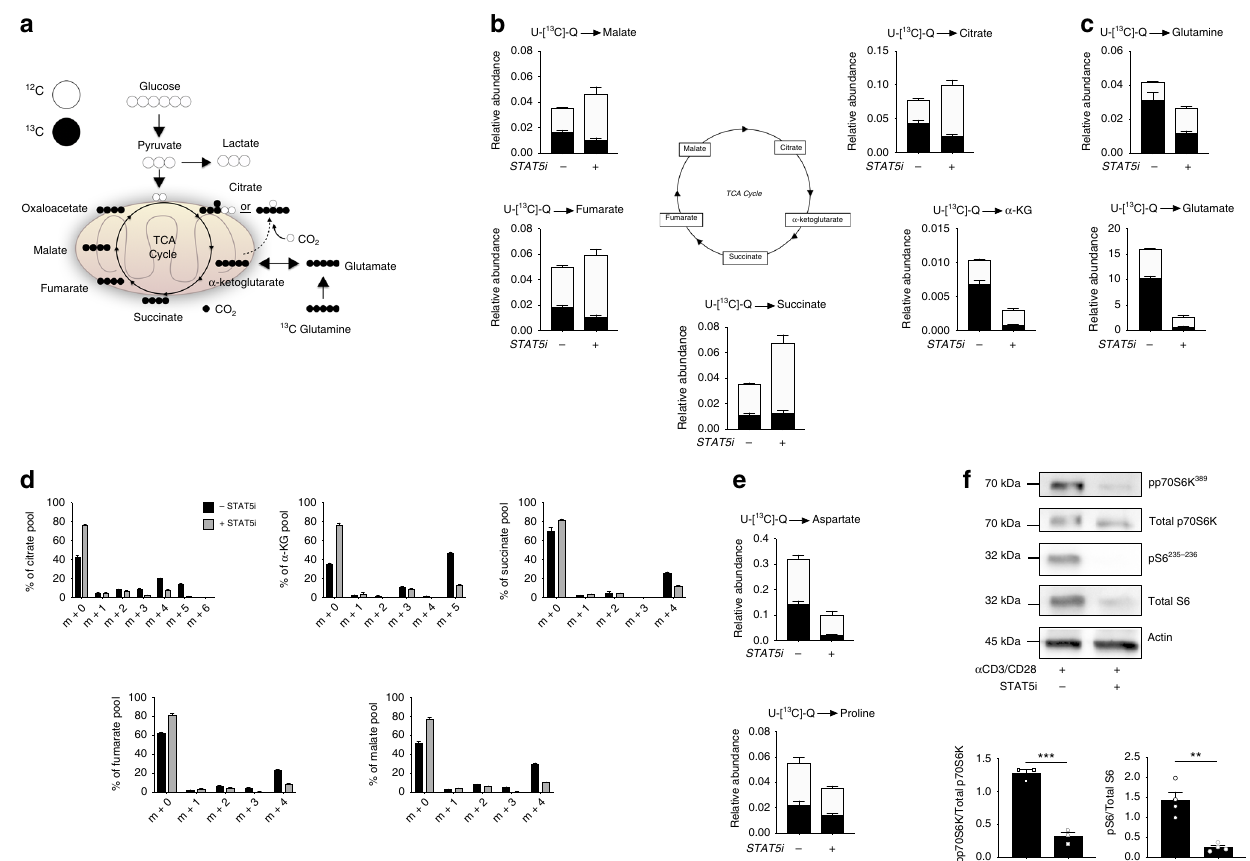
Fig. 6 STAT5 regulates glutaminolysis in an mTORC1-dependent manner. a Schematic summarising incorporation of uniformly labelled 13 C-glutamine into the TCA cycle. NV T-cells were activated (anti-CD3/CD28) in the presence or absence of STAT5i (100 μ M) for 4 h. b Relative abundance of glutamine- derived 12 C and 13 C TCA cycle metabolites, citrate, α -ketoglutarate, succinate, fumarate and malate. c Relative abundance of glutamine-derived 12 C and 13 C glutamine and glutamate. d Mass isotopologue distributions (MID) of TCA cycle intermediates, citrate, α -ketoglutarate, succinate, fumarate and malate. e Relative abundance of glutamine-derived 12 C and 13 C amino acids aspartate and proline. f Immunoblot for p70S6K and ribosomal S6 phosphorylation (pS6) in NV T-cells following 4 h activation with (anti-CD3/CD28) in the absence and presence of STAT5i (100 μ M). β -actin was used as a loading control. Statistical analysis was performed using a paired t -test ( f ). Data are representative of four experiments ( b – e ) or three experiments ( c ) and are expressed as mean + SEM. **p ≤ 0.01, ***p ≤